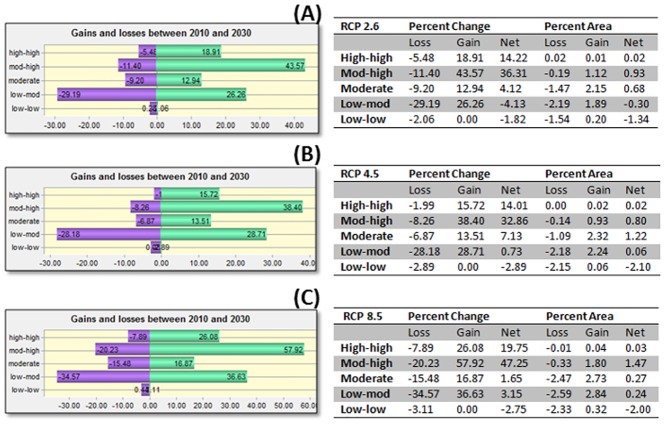
Change analysis into and out of 60% (0.6 probability) threshold category for Culicoides sonorensis occurrence probability as predicted with the Maximum Entropy algorithm under different climate change scenarios (Representative Concentration Pathways, RCP: RCP 2.6, RCP 4.5, RCP 8.5) projected for 2010–2030.Table represents both percent change and percent area of entire study area for loss, gain, and net change in pixels for each probability class category expressed as percentage (Low-low = 0–20%; low-mod = 21–40%; Moderate = 41–60%; Mod-high = 61–80%; and high-high = 81–100% probability of occurrence). Adjacent table visually indicates gains and losses (of percent change) for each class category. Percent change is defined by the number of pixels changed for a class divided by area of a class in later image, multiplied by one hundred. Percent area change is defined by the number of pixels changed for a class, divided by the total area of the land cover map, multiplied by one hundred.